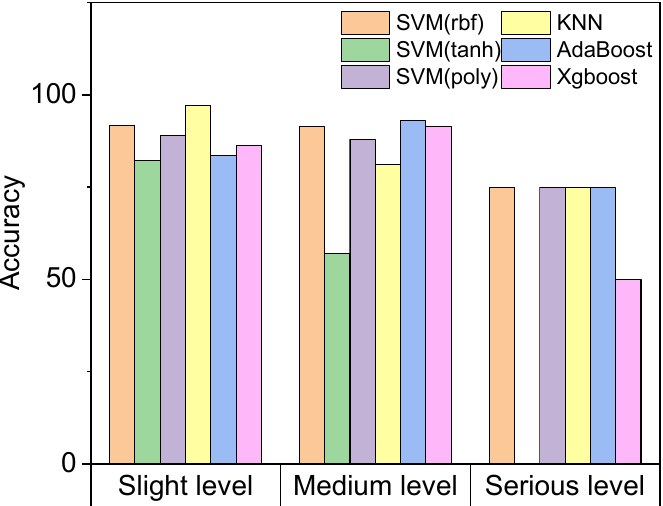
Figure 7. Accuracy of models on different neutralization levels of concrete.